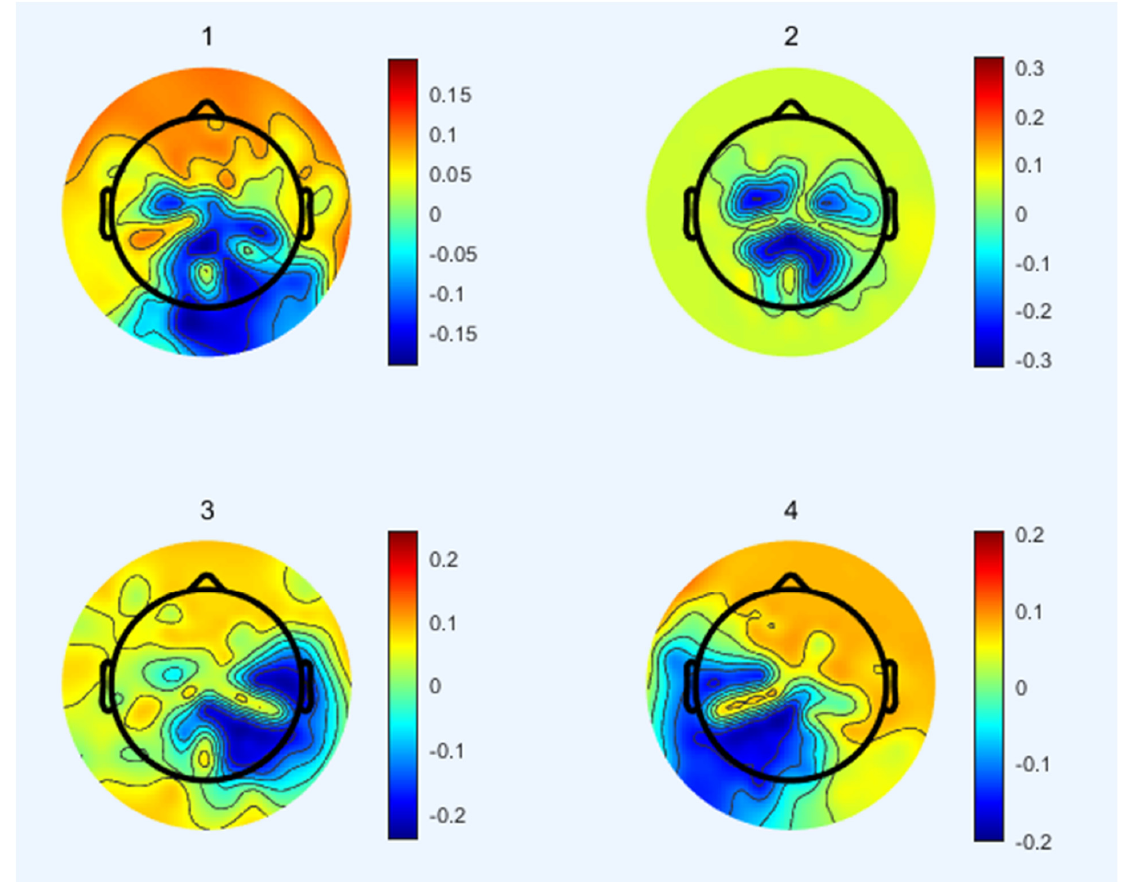
Figure 4. Topographies of the selected global microstate classes retrieved from the clustering algo- rithm for sub − bands.